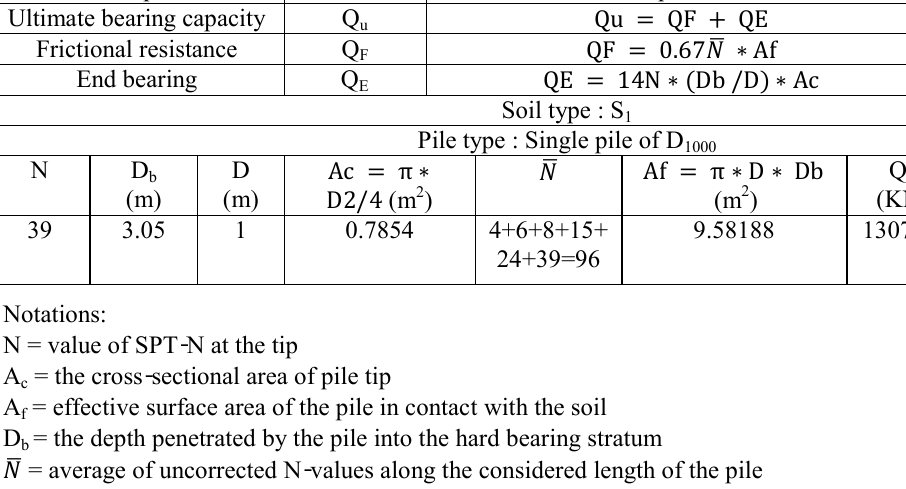
single pile in soil S 1000